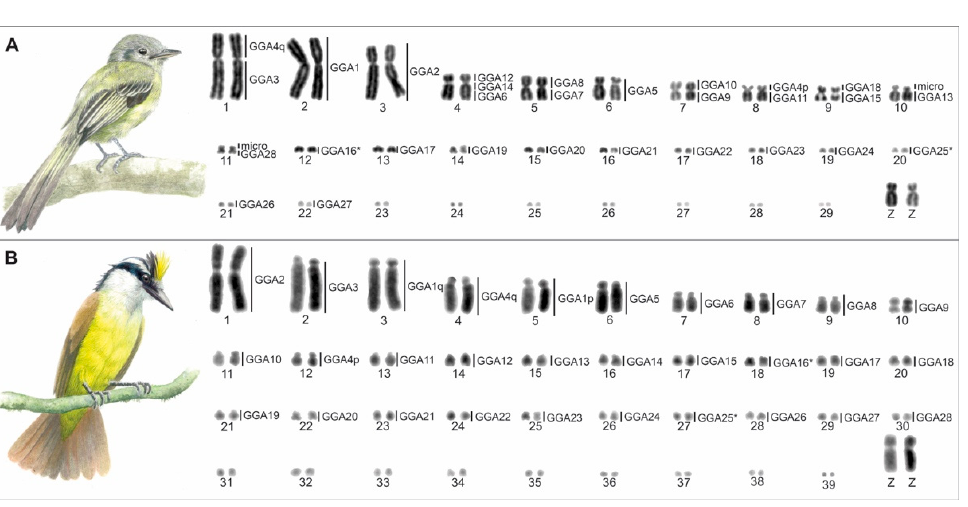
Figure 1. Conventionally stained complete karyotypes of Tolmomyias sulphurescens with 2n = 60 ( A ) and Pitangus sulphuratus with 2n = 80 ( B ) showing homologies to Gallus gallus (right). The homologies of P . sulphuratus macrochromosomes were based on Rodrigues et al. [15].